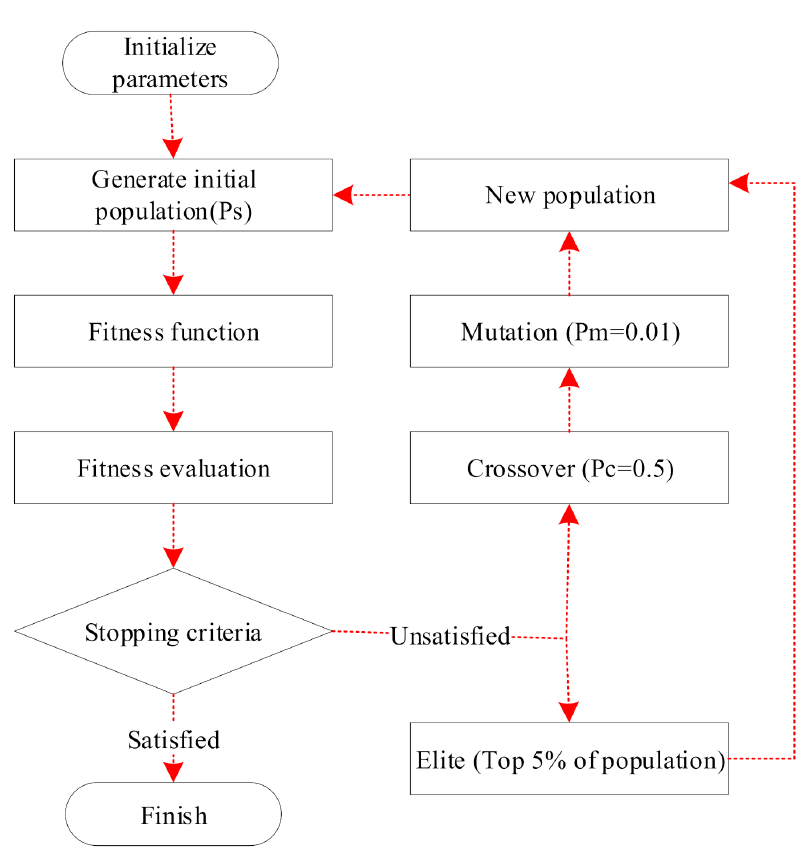
Figure 3. Genetic algorithm (GA) flow